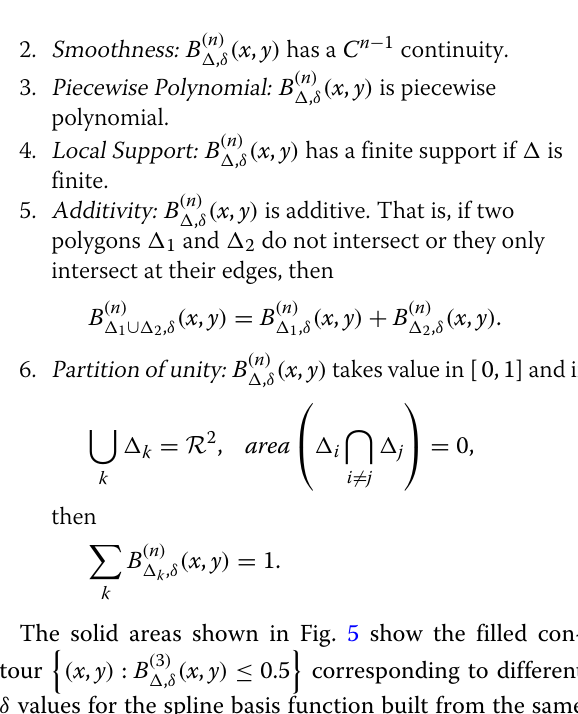
Fig. 5 The shapes of these areas are defined by the C 2 -smooth implicit function B ( 3 ) (cid:5) underlying control polygon for constructing B ( 3 ) (cid:5) values, which are δ = 0.05, δ = 0.15, δ = 0.25, ··· , δ = 0.55,